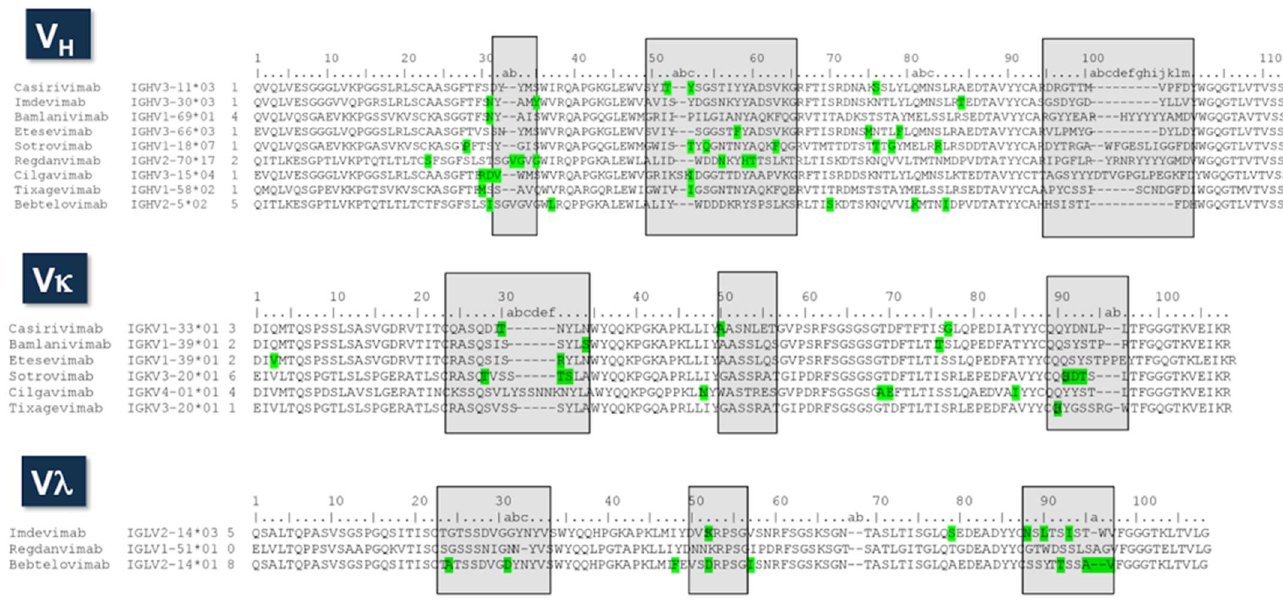
Figure 5. Sequence alignment of the therapeutic antibodies. The second column corresponds to the name of the IGHV, IGKV, or IGLV germline genes. The third column is the number of putative somatic mutations, indicated in green squares in the sequences. The germline genes were assigned using Ig BLAST (https://www.ncbi.nlm.nih.gov/igblast/ accessed on 16 May 2022). The CDRs are indicated in gray squares as defined using Kabat’s numbering convention.